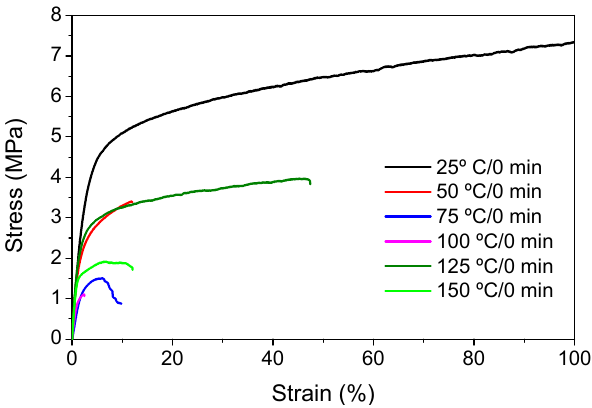
Figure 5. Stress–strain curves of representative PVDF membranes prepared at different dissolution temperatures.